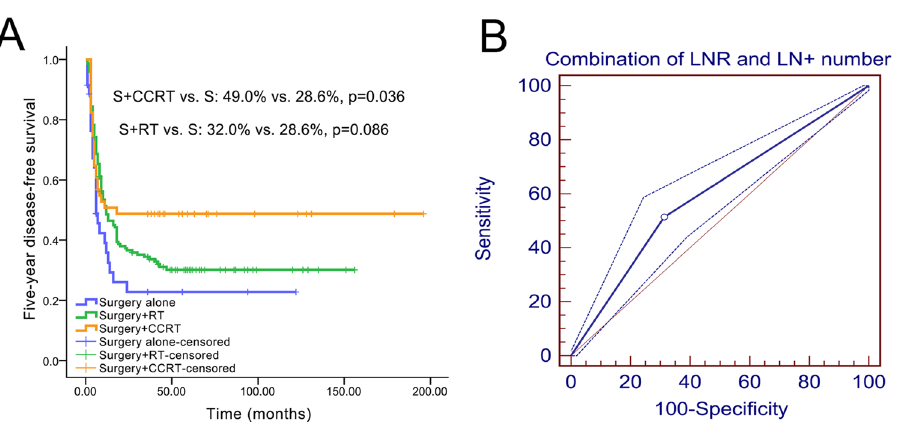
Figure 5. Kaplan-Meier and ROC curve analyses of 5-year DFS between the combination of the LNR and number of positive lymph nodes and management. ( A ) Five-year DFS survival curves; ( B ) 5-year ROC